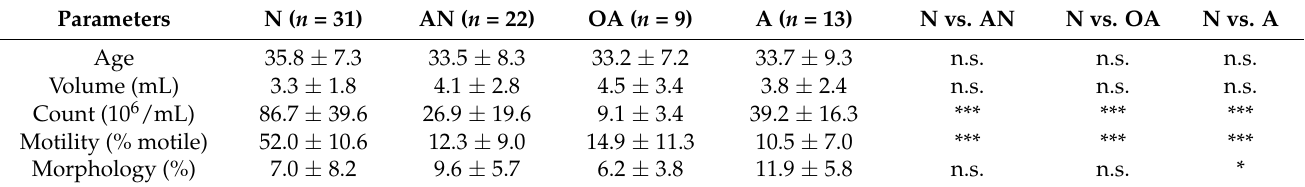
Table 1. Basic semen characteristics of the comparisons subfertile vs. normozoospermic controls (AN vs. N), oligoasthenozoospermic men vs. normozoospermic controls (OA vs. N) and astheno- zoospermic men vs. normozoospermic controls (A vs.